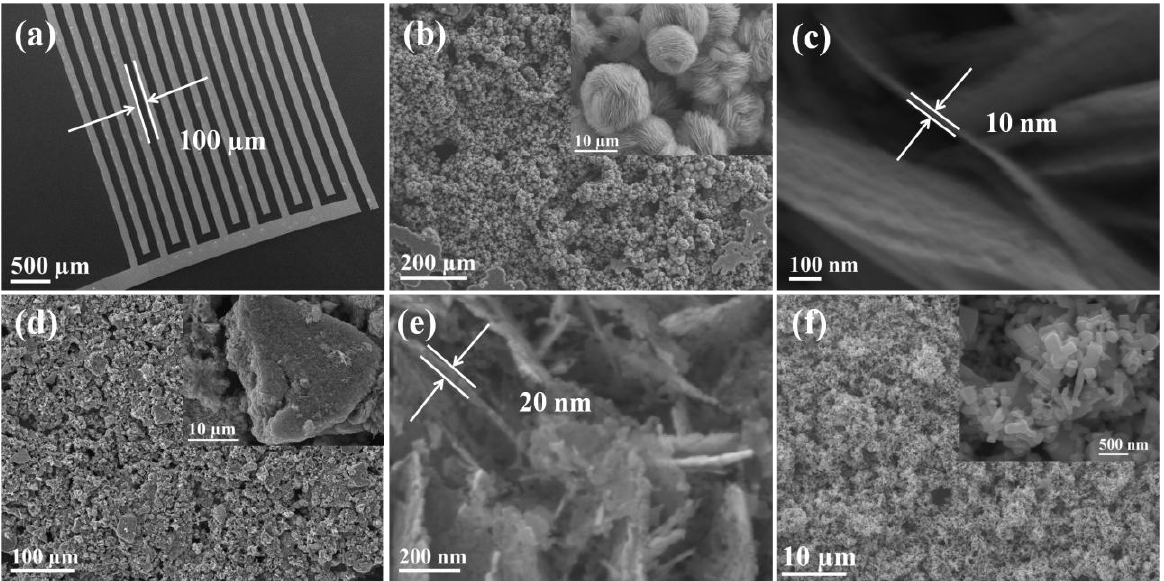
Figure 7. ( a ) SEM image of the pattern of gold interdigitated transducers on a SiO substrate; ( b ) low-magnification SEM image and enlarged image (inset) of the ZnO-F3 film on gold IDT; ( c ) high-magnification SEM image of the ZnO-F3 sample; ( d ) low-magnification SEM image and enlarged image (inset) of the ZnO-F5 film on gold IDT; ( e ) high-magnification SEM image of the ZnO-F5 sample; ( f ) low-magnification SEM image and enlarged image (inset) of the film of commercial ZnO nanoparticles on gold